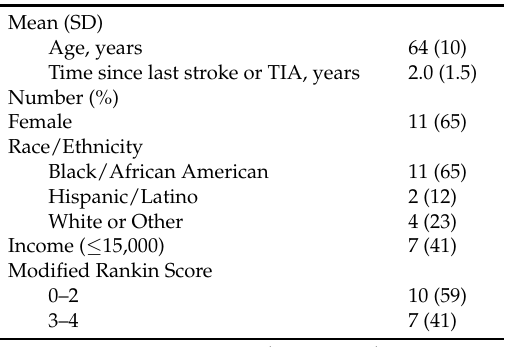
Table 1. Photovoice participant demographics (n =